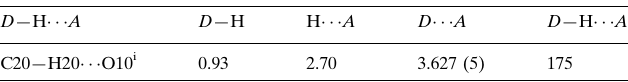
Hydrogen-bond geometry (A˚ , (cid:2)